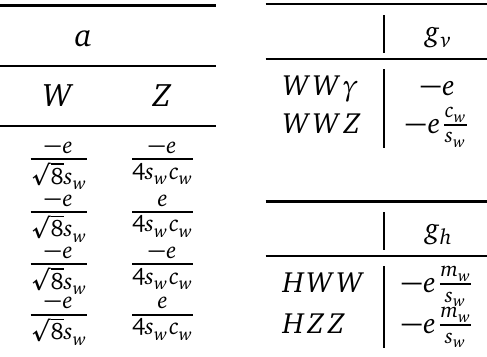
Table 1: Values of the EW coupling